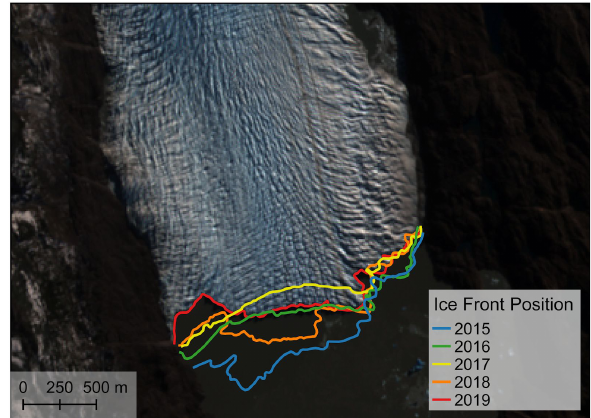
Figure 2. Tyndall Glacier’s ice front positions from 2015 to 2019.